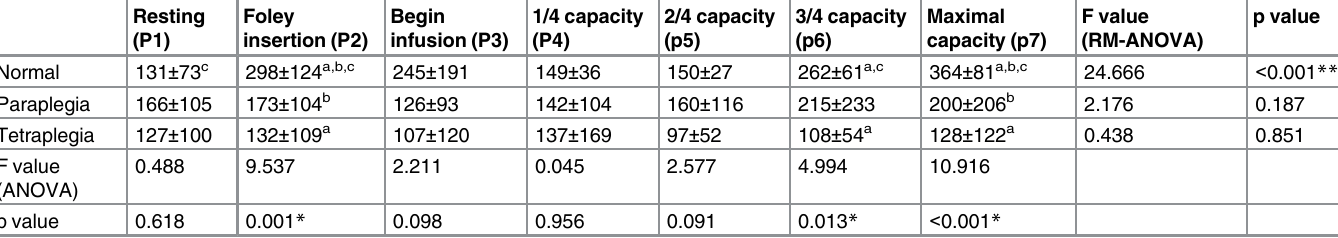
Table 3. Power spectrum analysis (LF/HF ratio) of HRV at rest, Foley insertion and during the process of bladder infusion. Resting Foley Begin 1/4 capacity (P1) insertion (P2) infusion (P3)